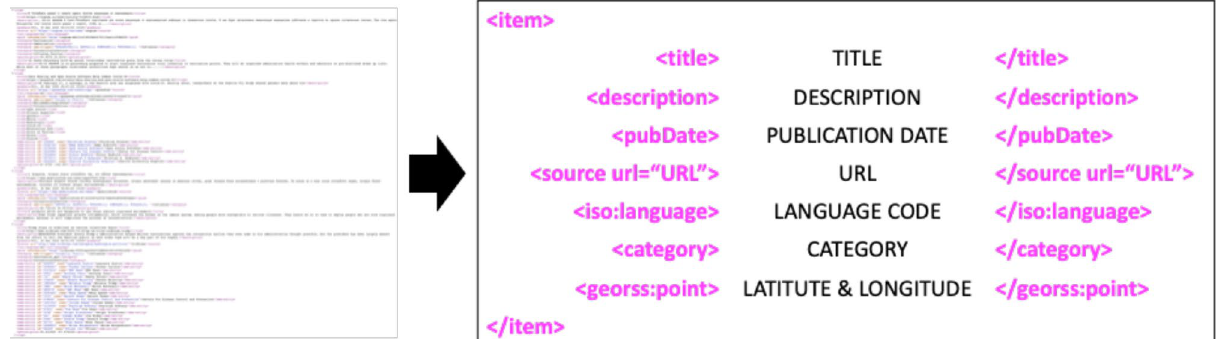
Figure 1. Examples of data provided by Medisys in the form of RSS and components of RSS provided by Medisys.